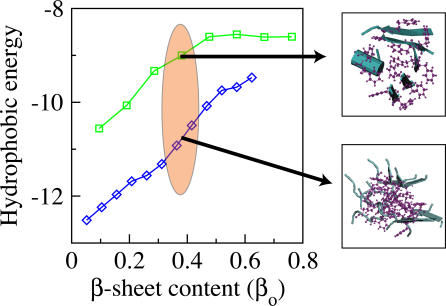
Surface-to-Volume Dependence for the Exposure of Hydrophobic Residues in Oligomeric SpeciesAverage hydrophobic energy per peptide for oligomers containing six peptide molecules (i.e., Nc = 6, green line) and 11 peptide molecules (i.e., Nc = 11 blue line) as a function of the β sheet content within the oligomer. As examples, two selected oligomeric configurations, both with the same degree of order, βo = 0.38, are shown on the right. Large oligomers have a lower surface-to-volume ratio, and this results in a smaller number of exposed hydrophobic residues per peptide molecule.